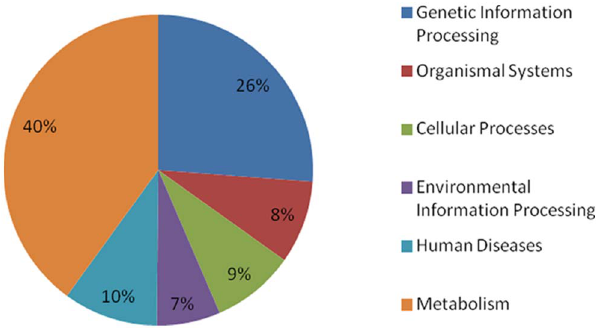
Figure 3. Pathway assignment based on KEGG mapping.